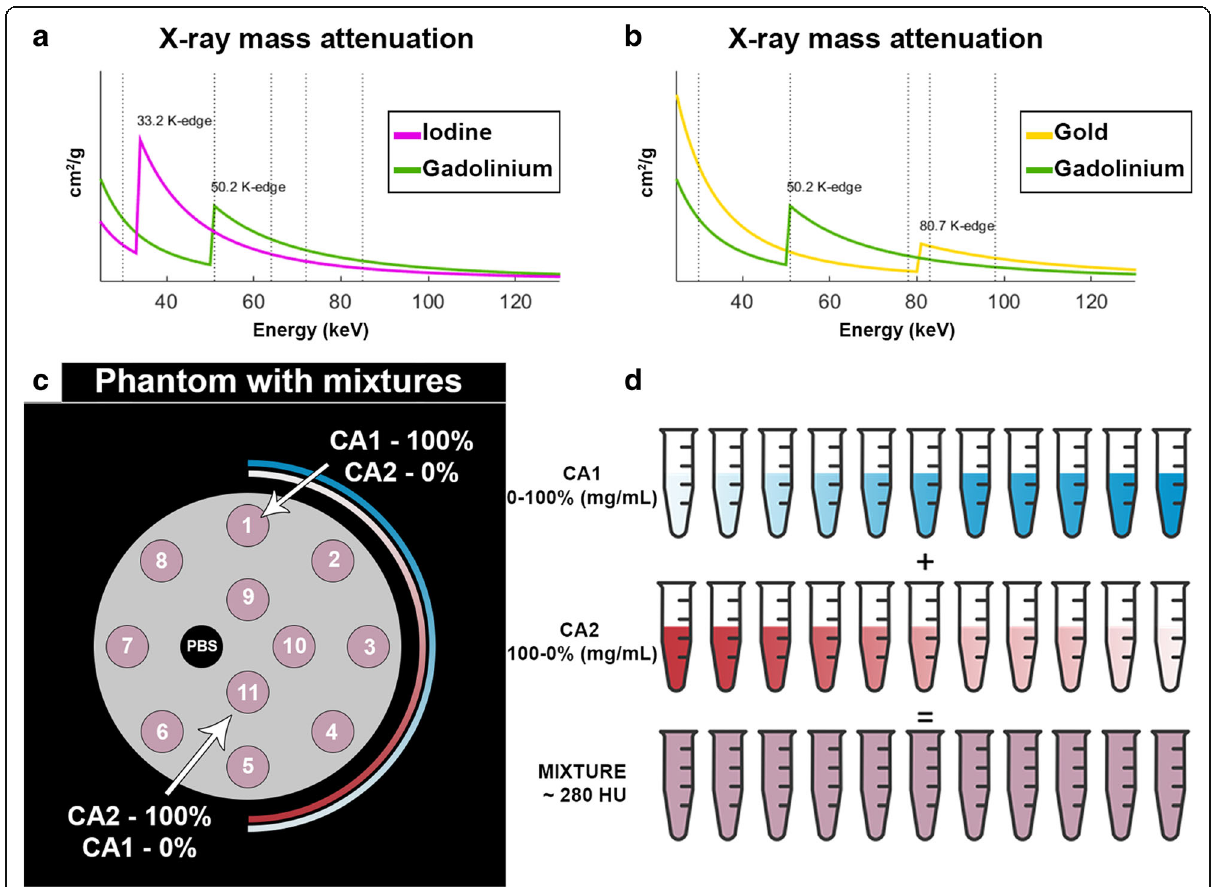
Fig. 1 Representation of the K-edge energies and thresholds ( dotted lines ) used for the characterisation of each element. x-ray mass attenuations of iodine ( purple ) and gadolinium ( green ) ( a ), as well as gold ( yellow ) and gadolinium ( green ) ( b ) are shown with solid lines . c , d Eleven tubes of mixed contrast agents were prepared. The solutions were organised in a spiral, such that contrast agent 1 (in blue ) was prepared at a decreasing concentration while contrast agent 2 (in red ) was prepared at an increasing concentration. The tubes in the phantom have the same colour on the schema because of their same-targeted CT attenuation values (~ 280